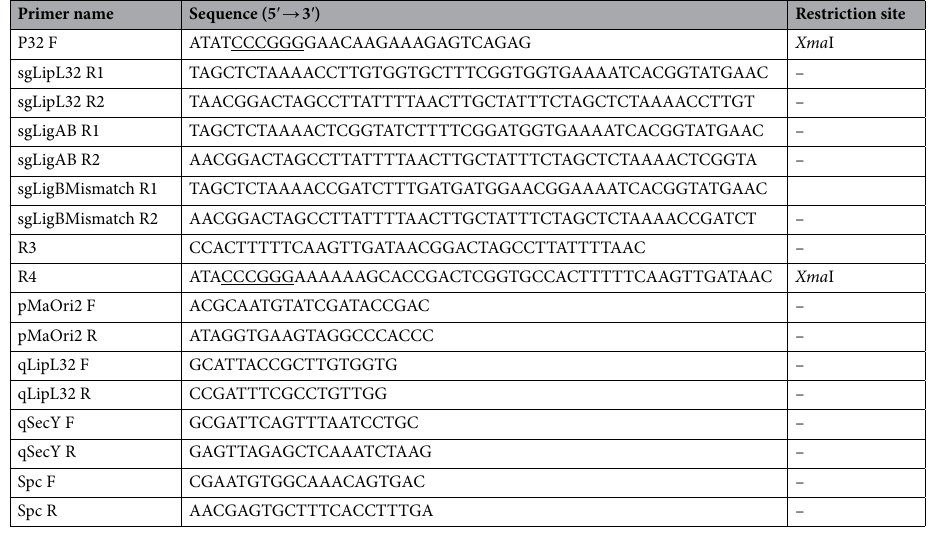
Table 2. Primers. Underlined nucleotides denote restriction